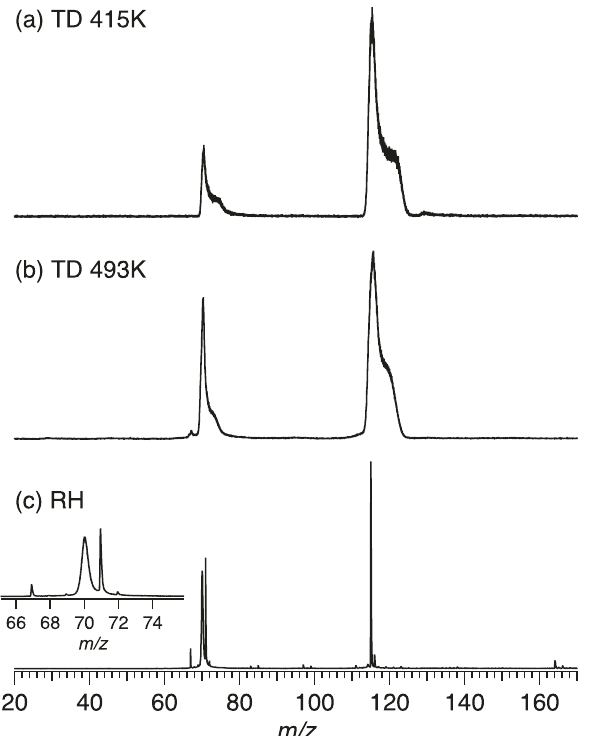
Fig. 11 Time-of- fl ight mass spectra (TOF) of proline recorded at 8.7 eV. a TD 415 condition. b TD 493 condition. c RH condition (ROI fi ltered) with a zoom in the m / z 65 – 76 range. The fragments at m/z 67, 69, 71 and 72 are clearly decomposition products in the oven. The asymmetric shapes of the peaks in a and b are the product of off-axis ions due to the large interaction region and the inhomogeneous extraction fi eld (see ref. 84